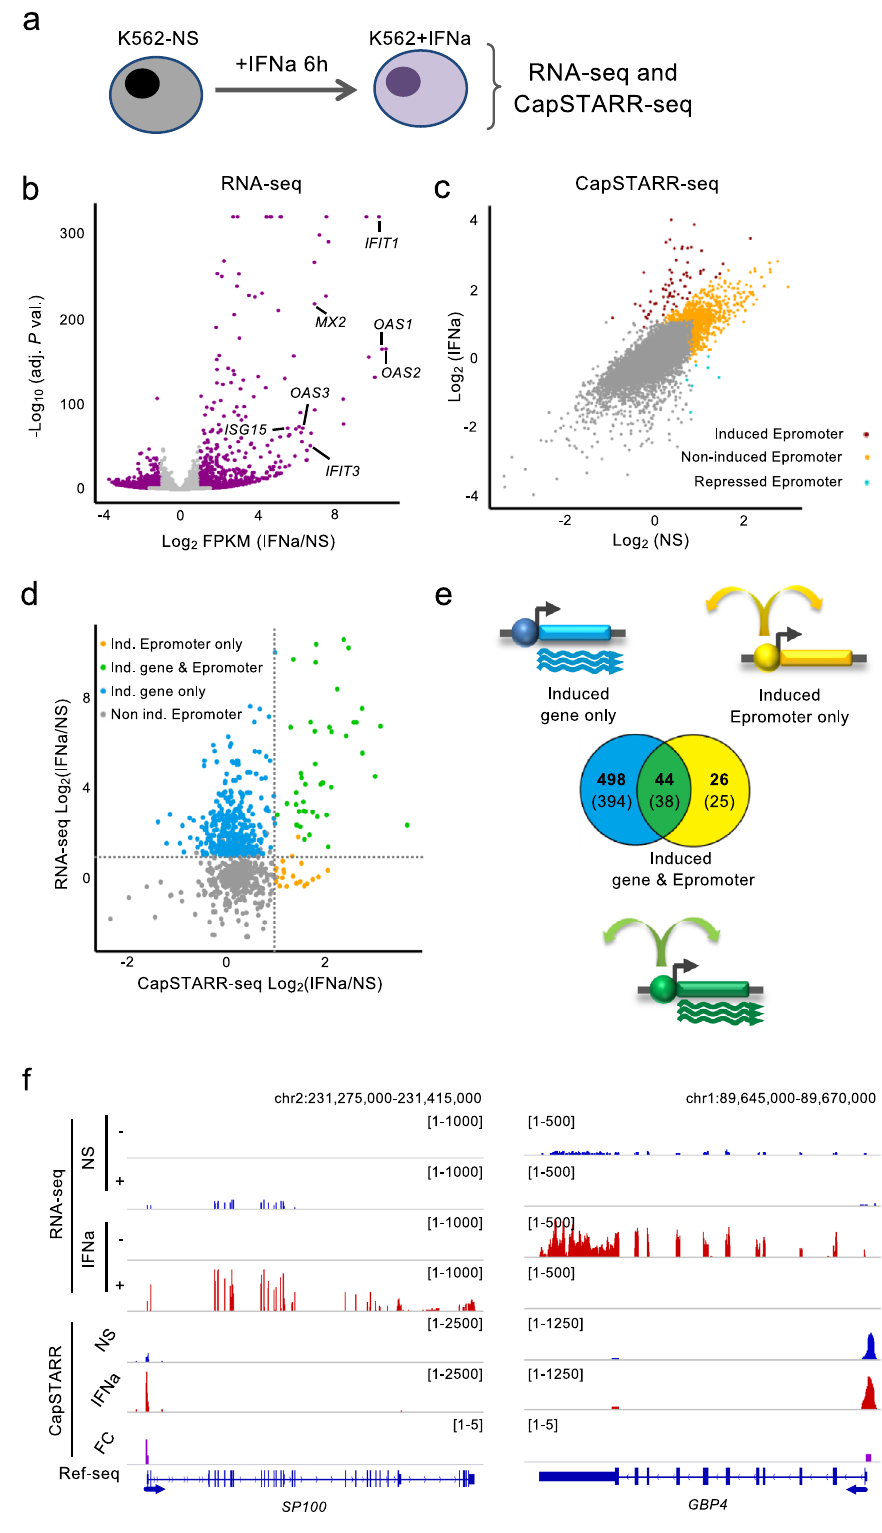
Supplementary Data 1). Combining the RNA-seq and CapSTARR-seq experiments allowed us to de fi ne three sets of IFNa-response loci in K562 cells (Fig. 1d, e and Supplementary Data 2): (i) 498 promoters associated with 394 IFNa-induced genes but without induced Epromoter activity (induced gene only), (ii) 44 promoters with induced Epromoter activity and associated with 38 IFNa-induced genes (induced gene &